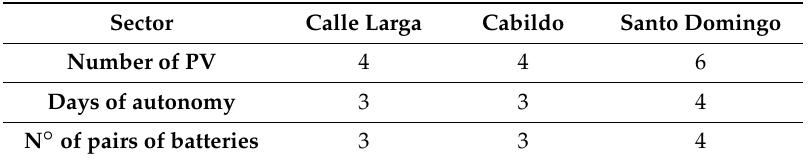
Table 7. Summary of results for the number of photovoltaics (PVs), days of autonomy, and pairs of batteries, by sector for the most critical